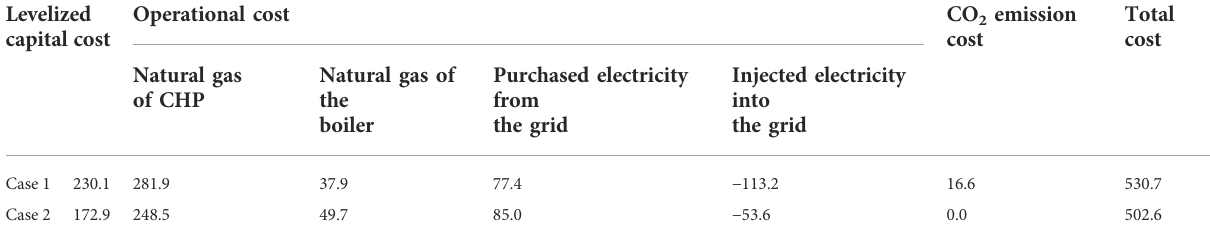
TABLE 7 Composition of the total cost of two cases considering different objectives